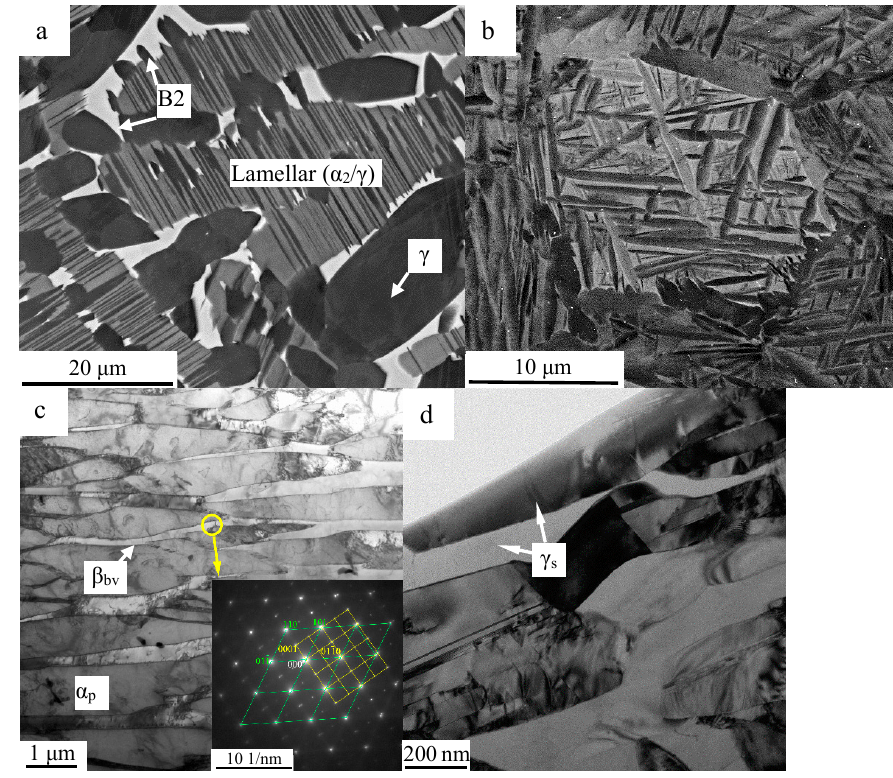
Figure 1. Back-scattered electron mode of the scanning electron microscope (SEM - BSE) images of the ( a ) as-cast and ( b ) copper-quenching microstructures of Ti-44.5Al-8Nb-2.5V alloy and ( c , d ) TEM images of the copper-quenching Ti-44.5Al-8Nb-2.5V microstructures.